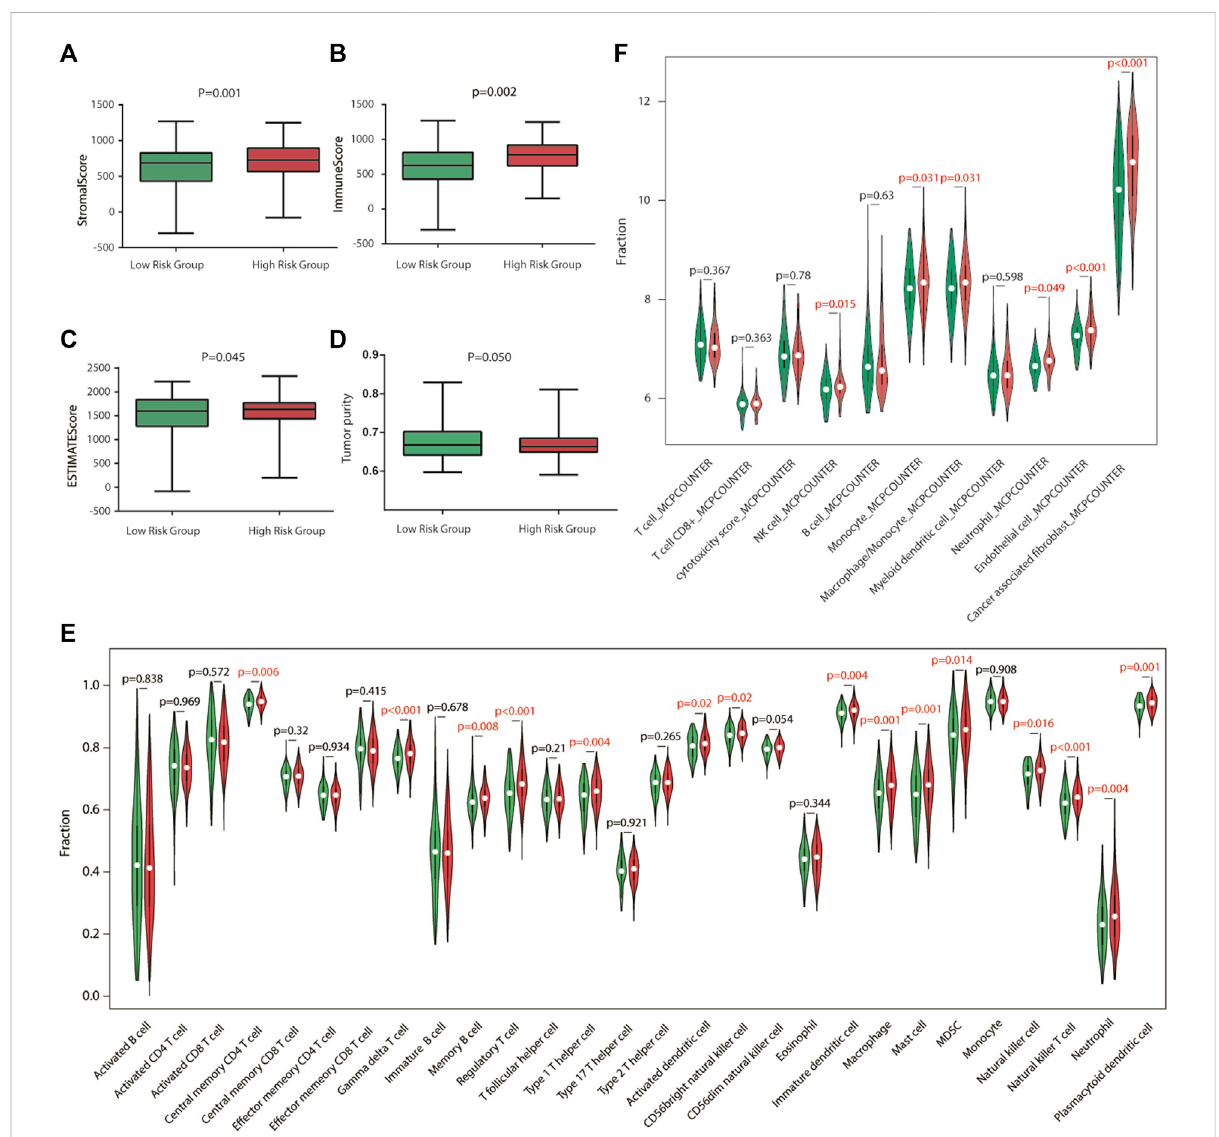
FIGURE 6 Immune characteristics of the GEO validation cohort. (A – D) Estimation of the proportion of immune-stromal component and tumor purity. Immune score, stromal score, ESTIMATE score (the sum of them), and tumor purity between different risk groups in the GEO validation cohort. (E) Different in fi ltrating abundances of 28 TIICs estimated by ssGSEA between subgroups. (F) Different in fi ltrating abundances of 11 TIICs estimated by MCP-counter between